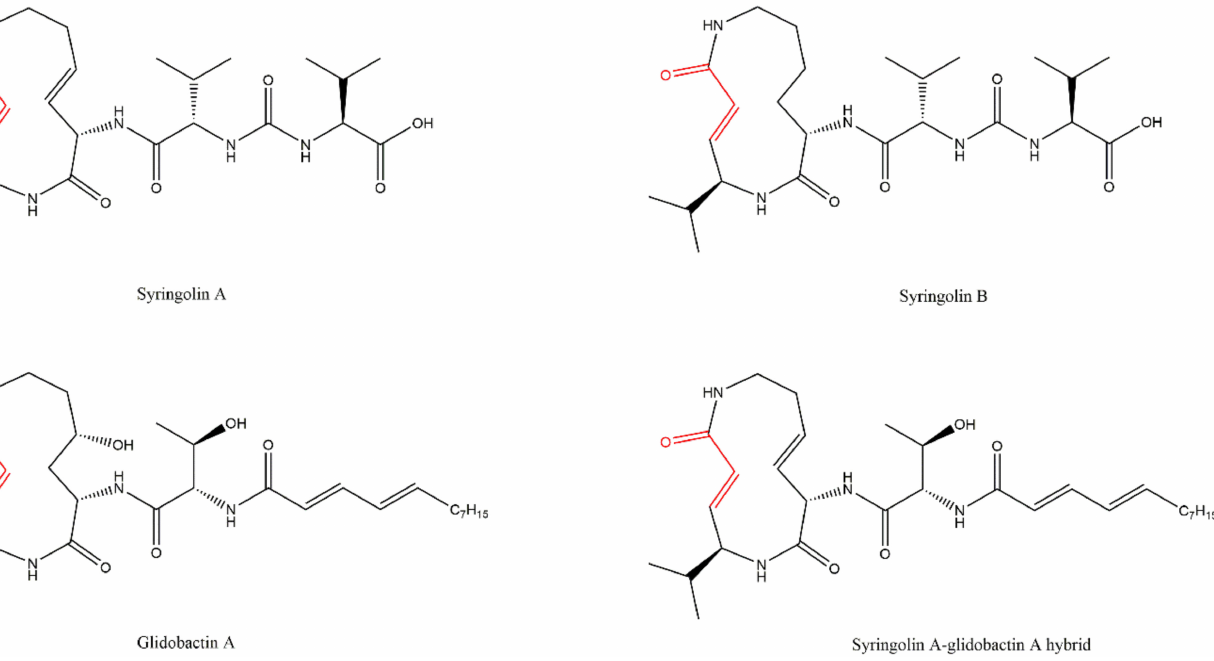
Figure 20. Examples of syrbactin inhibitors